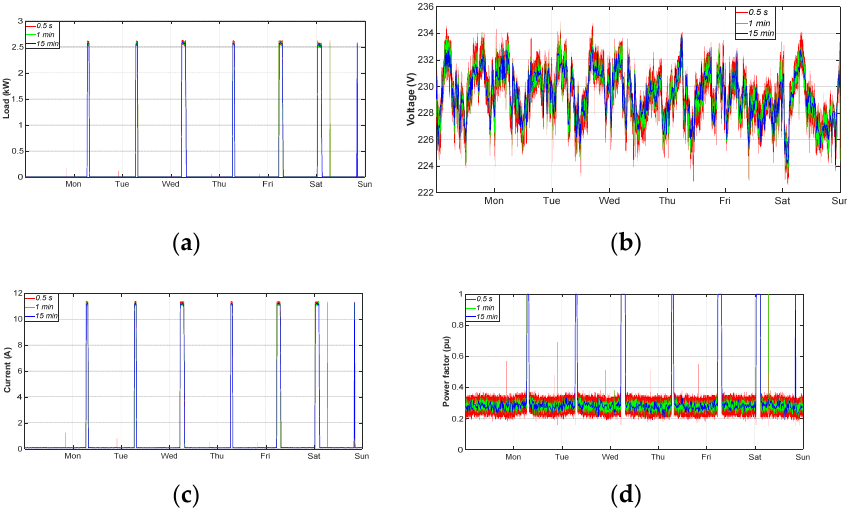
Figure 15. Weekly electrical data for PV: ( a ) power, ( b ) voltage, ( c ) current and ( d ) power factor.